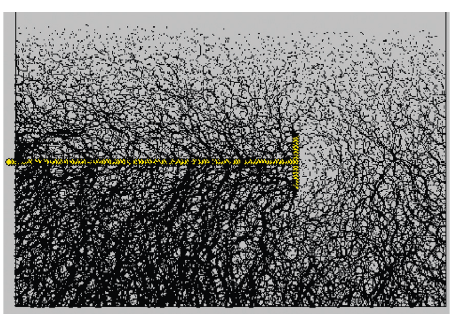
Figure 15: Contact stress after